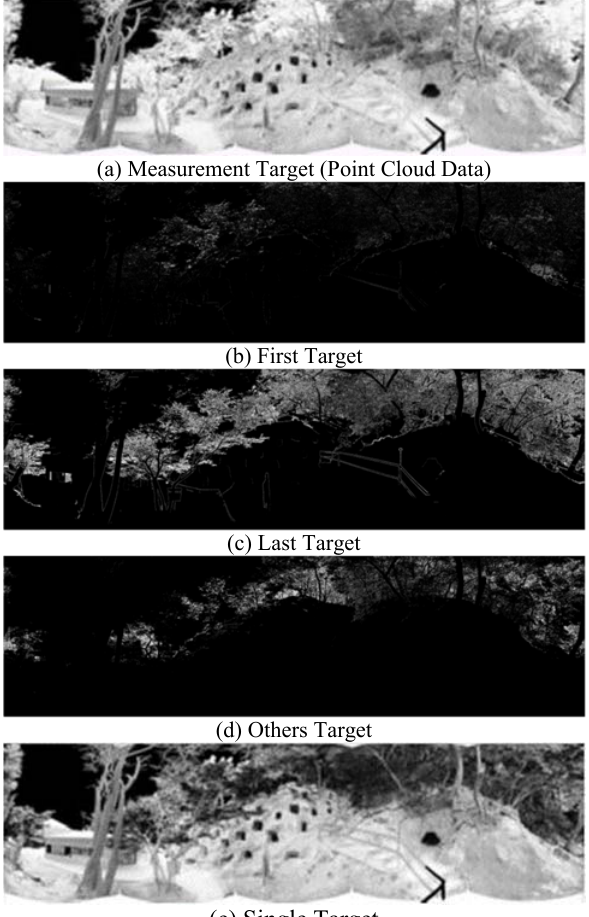
Figure 3. Measurement results by the reflection